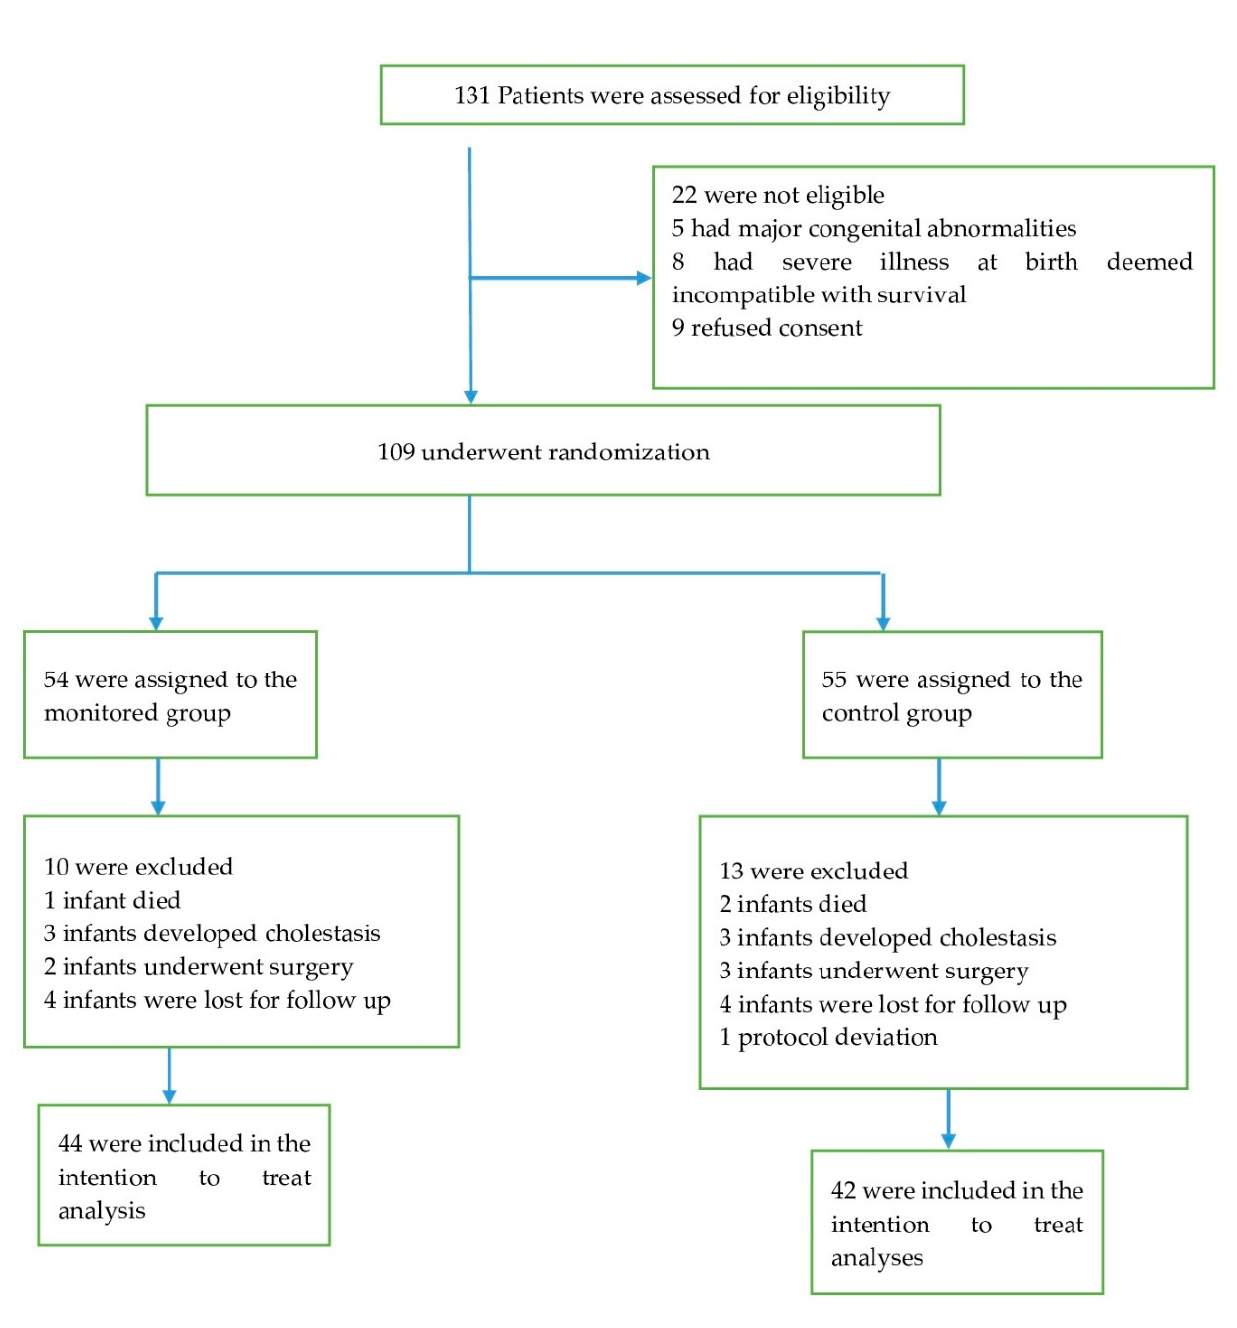
Figure 2. Patient recruitment characteristics.